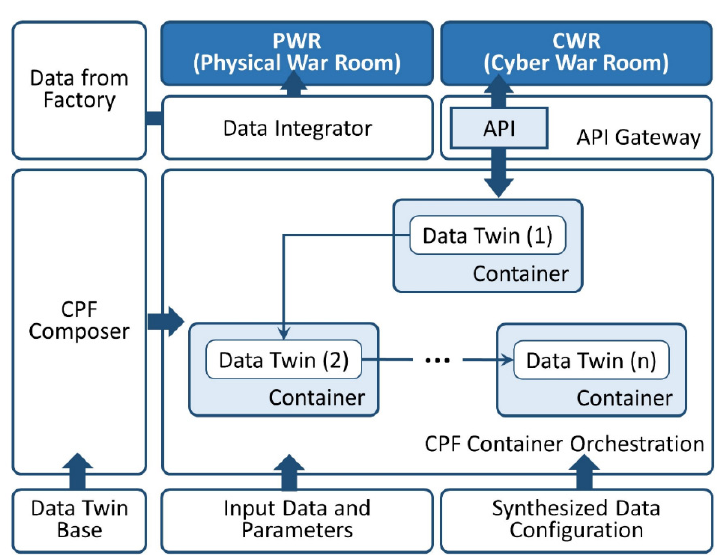
Figure 5. The architecture of the Cyber-Physical Factory.